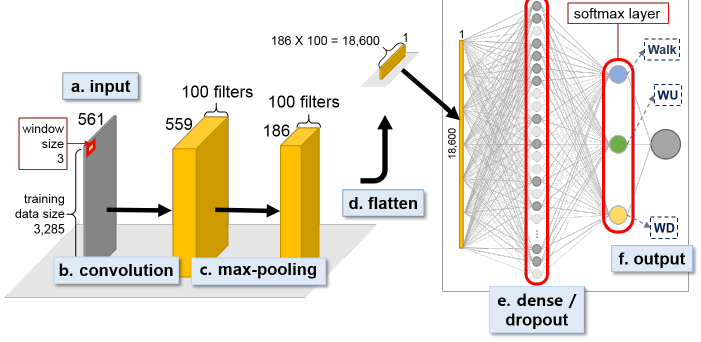
Figure 10. Second-stage 1D CNN for classifying dynamic activity, i.e., Walk, WU, and WD, for UCI HAR dataset.